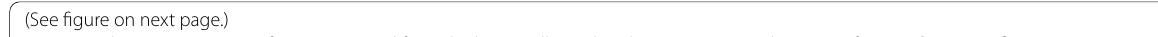
(See figure on next page.) Fig. 5 Real-time monitoring of ROS generated from the living cells on the plasmonic NP-graphene interface. a – d Immunofluorescence images of the normal cell (HDF) and cancer cell (A375P) cultured on the glass slide. a , b ), plasmonic SNP-graphene interface; c , d (i) F-actin (green), (ii) α-tubulin (red), (iii) Nuclei (blue), and (iv) merge. The scale bars represent 40 μm. e – g Time-resolved spectral changes induced by ROS generated from the cells under three different cellular conditions, including normal cells ( e ), NaAsO 2 -exposed normal cells ( f ), and cancer cells ( g ). h Plots of time-resolved changes in the quenching dip at 550 nm induced by ROS in e – g . (i) Quantitative analysis for DCFDA intensity in fluorescence images of intracellular ROS in Additional file 1: Fig. S7 (n 10 for each group). Statical analyses were performed using one-way ANOVA (** indicates p = *** represents